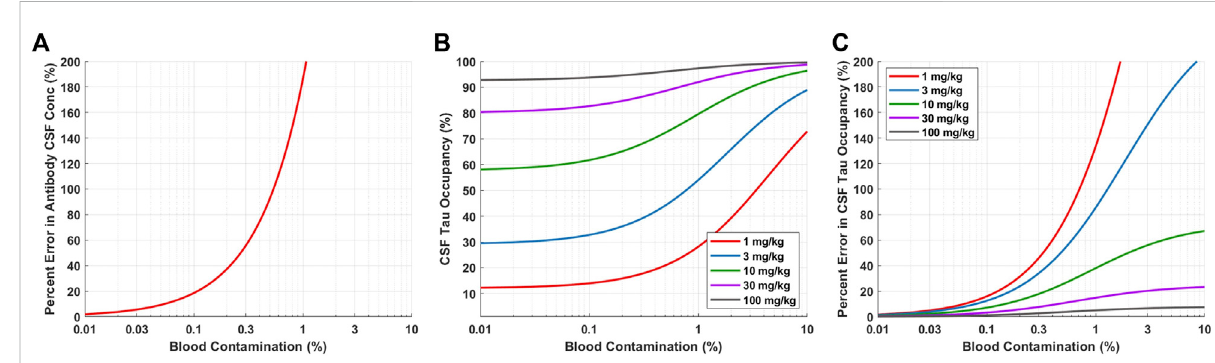
Model predictions for impact of blood contamination on antibody concentration and tau occupancy in CSF. (A) Predicted percent error in CSF concentration of Antibody A for various levels of blood contamination. (B) Predicted CSF tau occupancy for various doses and levels of blood